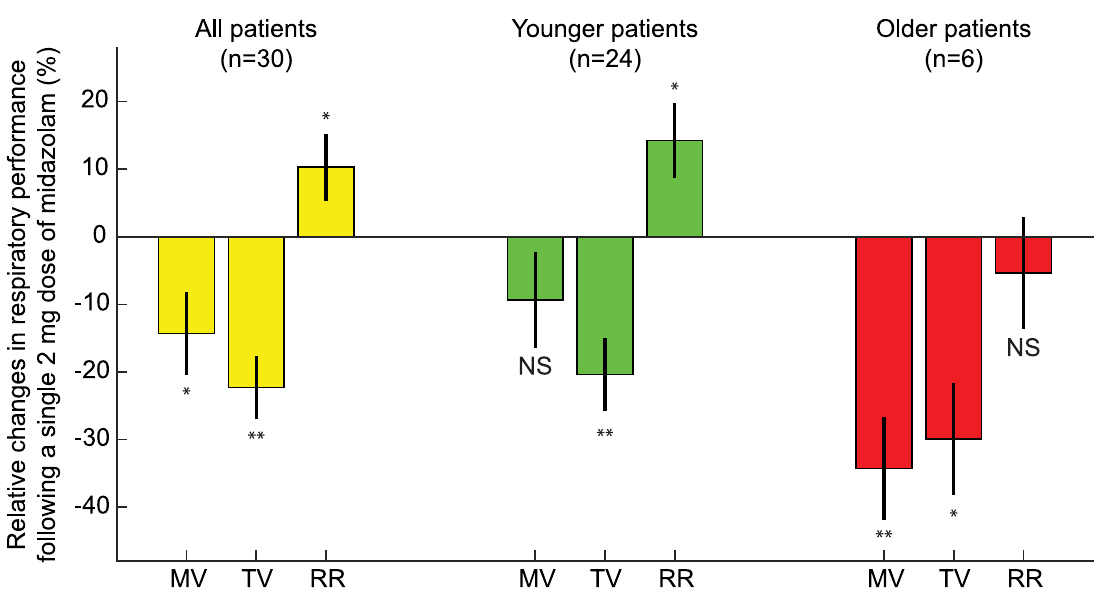
Fig 5. Age-specific analysis of respiratory depression following administration of 2mg of midazolam. Average changesin MV, TV, and RR followingmidazolamare shown for all patients (yellow), youngerpatients (green), n = 24, age 43 ± 14years, and older patients (red), definedas 65 years and older, n = 6, age 70 ± 6 years. Both the young and elderly demonstrated significantdecreases in TV (20% ± 5% and 30% ± 4% respectively, p < 0.05for both). In youngerpatients this decreaseof TV was coupledwith a significantincreasein RR (14% ± 5%, p < 0.05)leadingto a marginaland not significant decreasein MV (9% ± 6%, p < 0.05).In contrast, in the elderly patients RR did not increase,but in fact, slightly decreased (5% ± 4%, p > 0.05)and the resulting MV was significantly lower, with an averagedecreaseof 34% ± 6% (p <